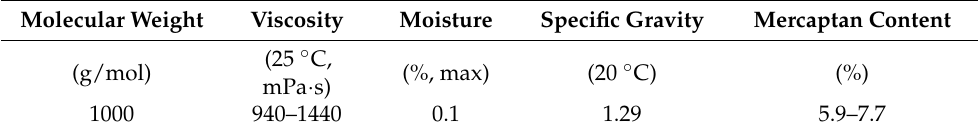
Table 2. Physical properties of the polysulfide liquid polymer LP-3.